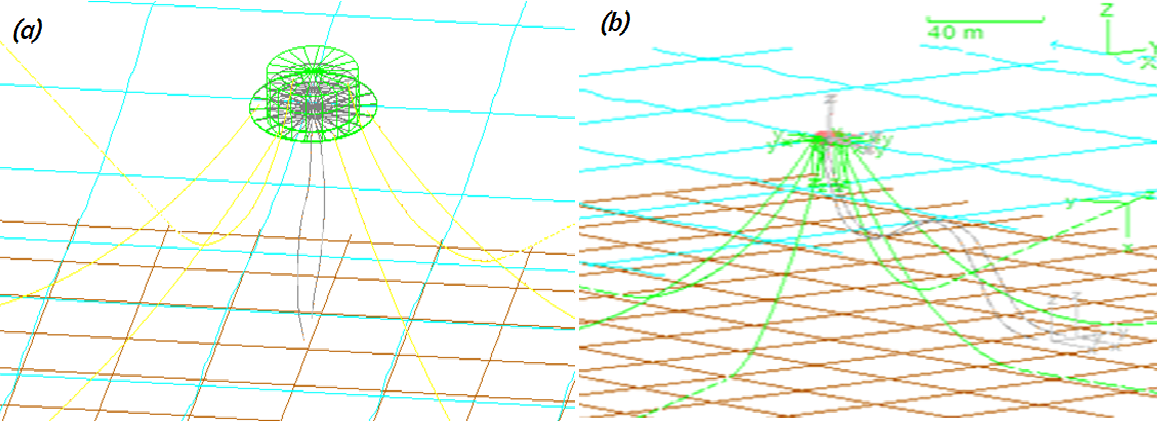
Figure 11. The Orcaflex line theory depicting (Adapted, courtesy of Orcina; Source: [127,128]).